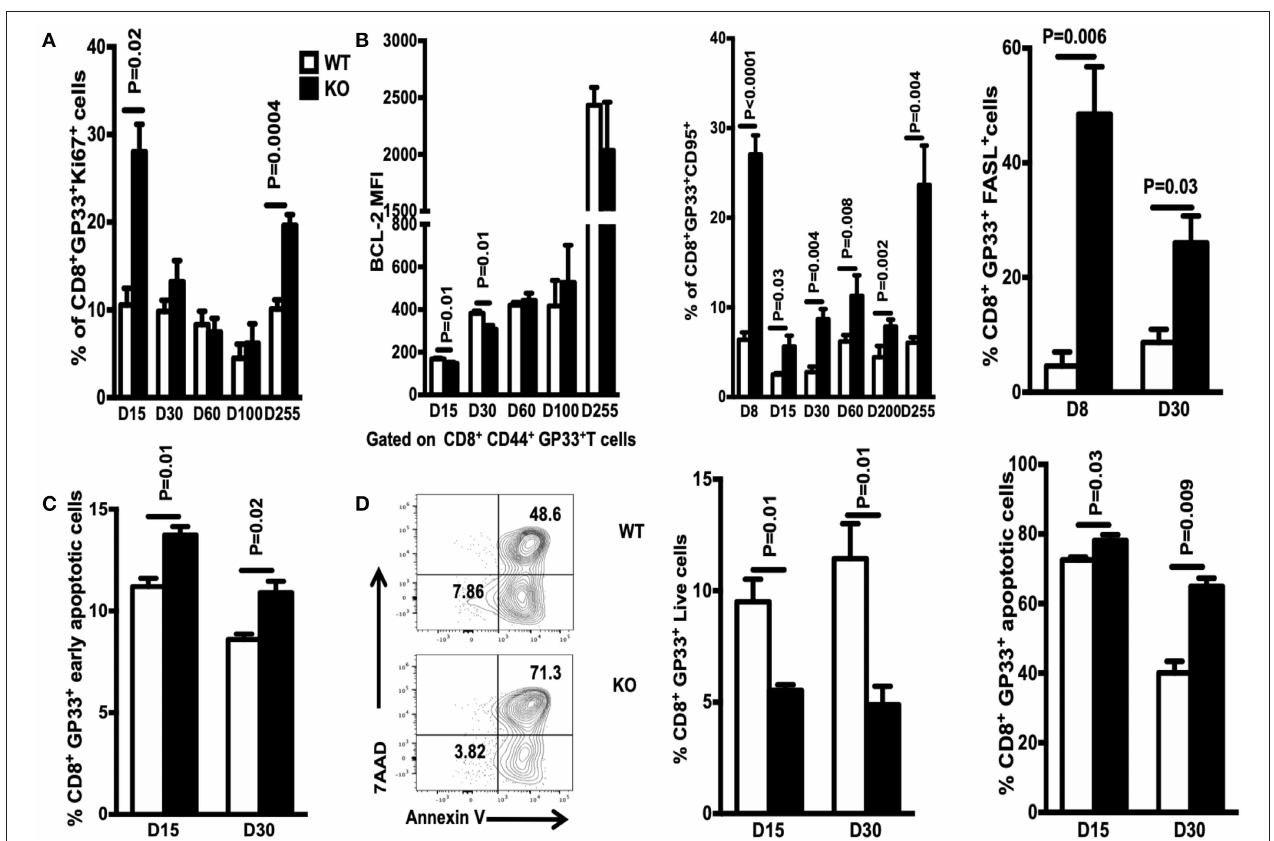
FIGURE 7 | GP33-specific CD8T cells from WASp − / − mice display increased apoptosis. Spleenocytes were stained for CD8, CD44, Db/GP33 tetramer, FAS, and FASL. Ki67 and BCL-2 were detected by intracellular staining (A) Percentage of Ki67 + cells within the GP33-specific CD8 + T cell population in the spleen on the indicated days. (B) Left panel, expression of BCL-2 by GP33-specific CD8 + T cells on indicated days; middle and right panels, percentage of FAS- and FASL-positive cells within the GP33-specific cell population in the spleen on the indicated days. (C) Apoptosis was determined by staining with antibodies specific for CD8 and CD44, the Db/GP33 tetramer, and with 7-AAD, and Annexin V immediately after isolation on D15 and D30 PI. (D) Left panel, representative data showing apoptosis on D30 after culture of spleenocytes with GP33-41 peptide for 24h; middle and right panels, percentage of live or apoptotic GP33-specific T cells. Data